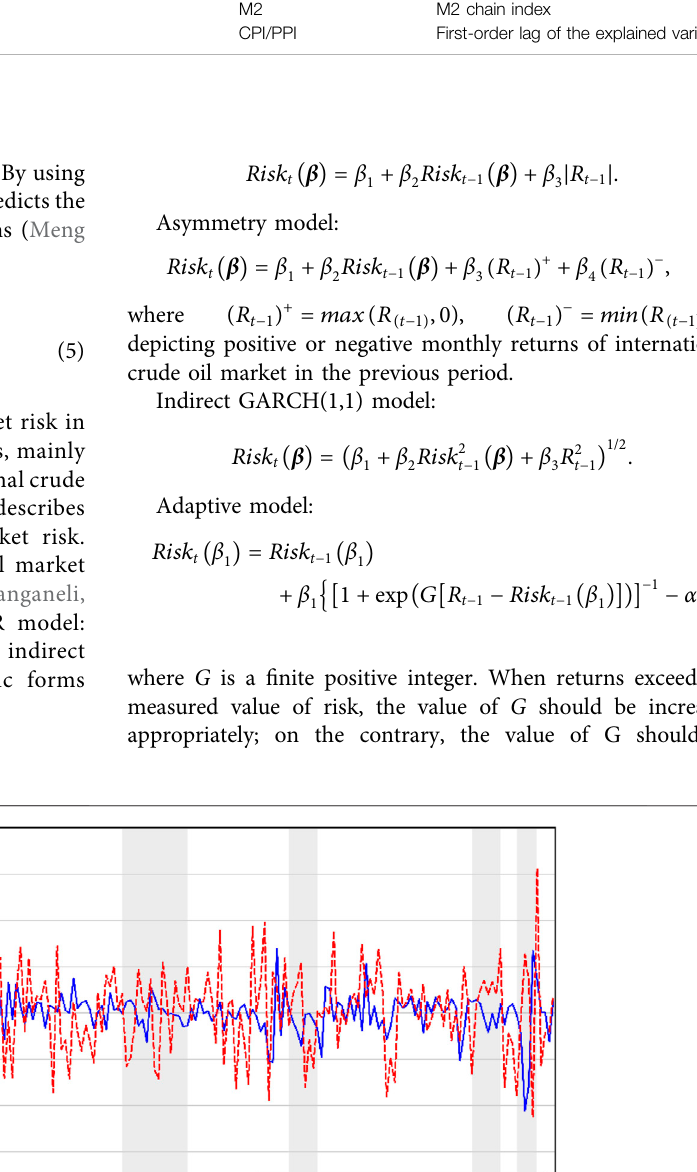
Frontiers in Energy Research |